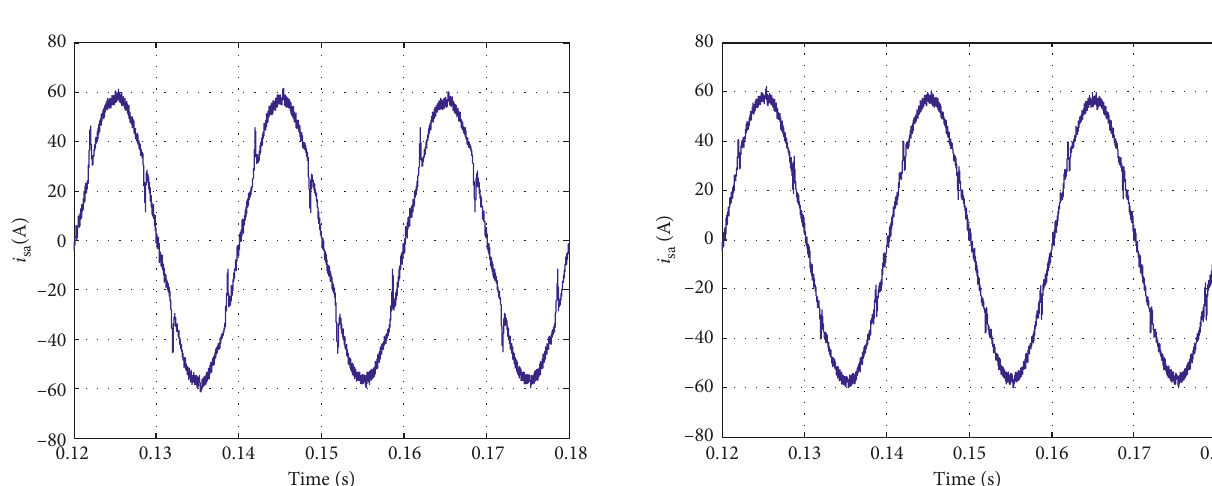
Figure 17: Waveform of source current using PI controller and multi-VR controllers.